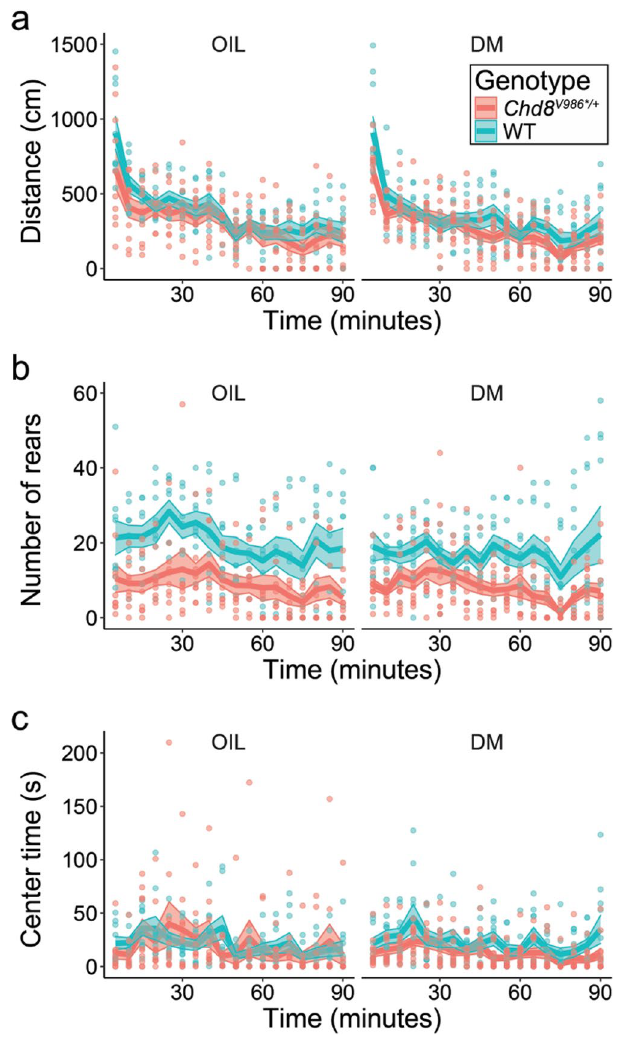
Figure 3. Open-field behavior in 12 month WT and Chd8 V986*/ + mice following DM exposure or oil control. (a) Distance traveled, (b) number of rears, and (c) time in center. Cohorts were tested for 90 min at 12 months of age to determine persistence of changes in activity and anxiety-like behavior. Data are means (± SEM). N = 10–12 mice per group. Fisher’s PLSD tests were used for comparing group means only when a significant F value was determined by using a two-way ANOVA, with genotype and treatment as